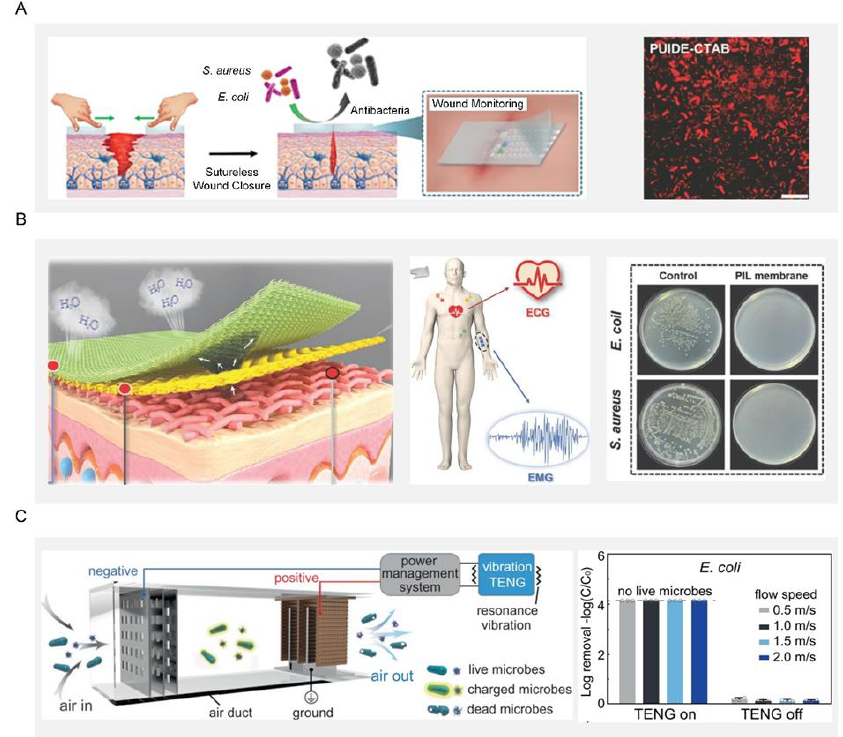
Figure 8. Applications of bioinspired antibacterial surfaces. ( A ) Schematic diagram of self-healing elastomer multifunctional wound dressing. Bacteria after being cocultured with PUIDE-CTAB for 6